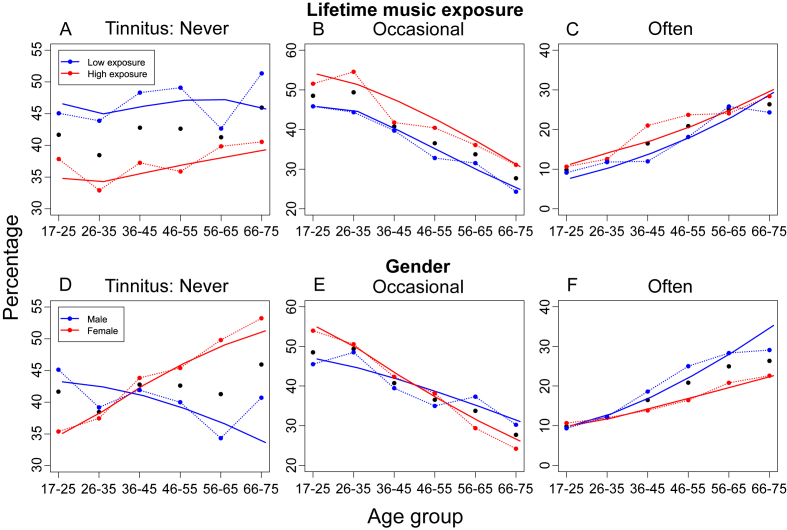
Music exposure and gender relation to tinnitus prevalence. Percentage respondents in each age group reporting each tinnitus frequency (black points; as in Fig. 2B). A-C. Relation to lifetime music exposure, divided into ‘Low’ and ‘High’. D-F. Relation to gender. For each figure, coloured points show mean data and lines show predictions from simplified multinomial regression models (Tinnitus ∼ Age + Music + Musicˆ2 and Tinnitus ∼ Age*Gender, respectively).